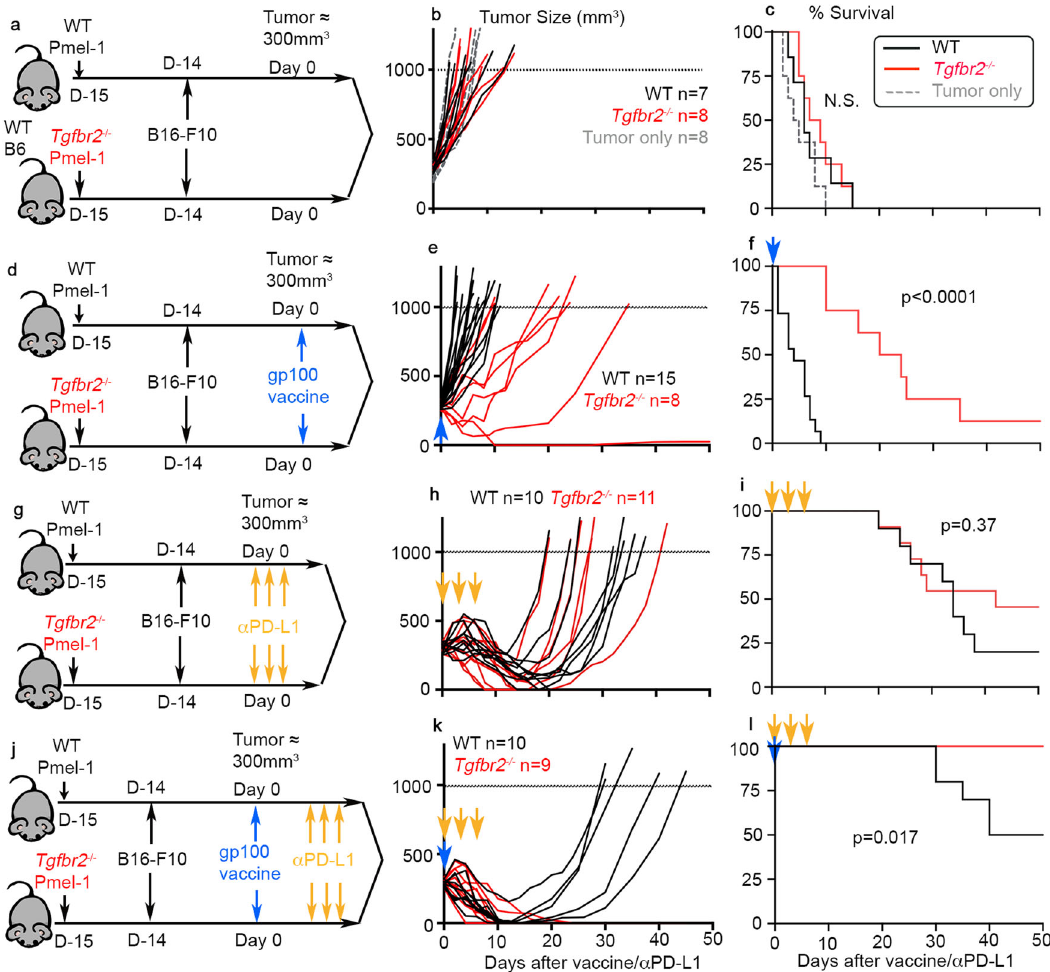
Fig. 1 | Tgfbr2 − / − CD8 + T cells exhibited greatly enhanced responses to tumor vaccine.a – c Pmel-1alone. a Schematics; b tumorgrowth; c survivalcurve.NoTcell transfer group is shown in gray dashed line. Black lines, WT Pmel-1 recipients and red lines, Tgfbr2 − / − recipients. For b and c , WT, n =7, Tgfbr2 − / − , n =8 and no cell group, n =8. d – f Pmel-1 +tumor vaccine (indicated as a blue arrow). d Schematics; e tumor growth; f Survival curve. For e and f , WT, n =15, Tgfbr2 − / − , n =8. g – i Pmel- 1+ α PD-L1 (indicated as yellow arrows). g Schematics; h tumor growth; i Survival